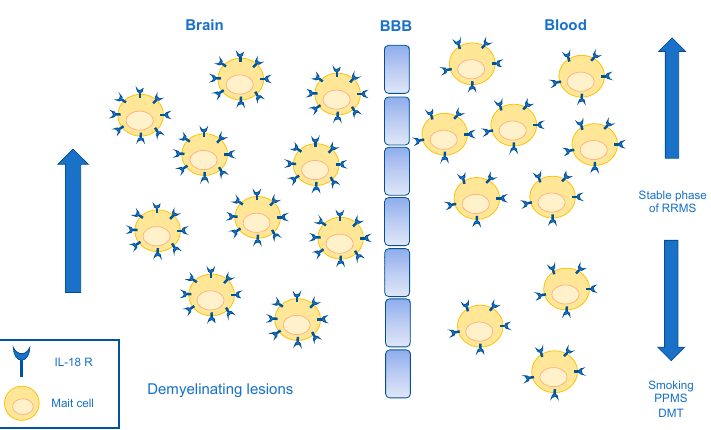
Figure 2. MAIT cell dynamics in multiple sclerosis. Abbreviations: MAIT = mucosal-associated invariant T cells; RRMS = relapsing-remitting multiple sclerosis; PPMS=primary progressive multiple sclerosis; DMT = disease-modifying therapies; IL18 R = interleukin 18 receptor; BBB = blood- brain barrier.